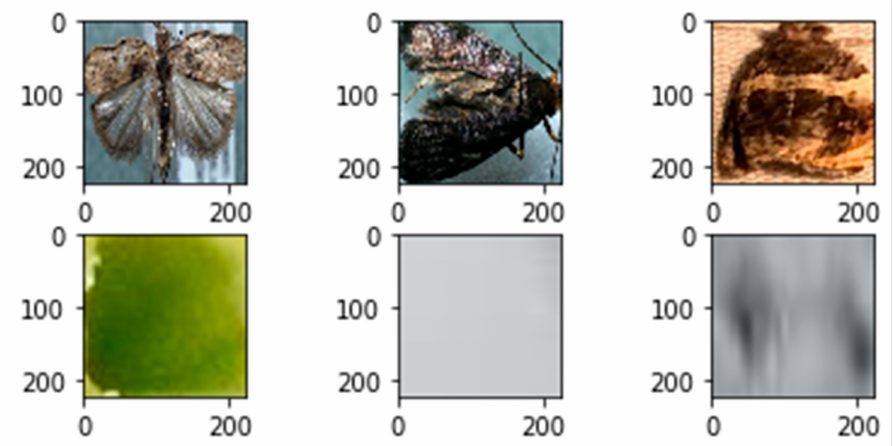
Figure 4. Three positive ( top row ) and three negative ( bottom row )